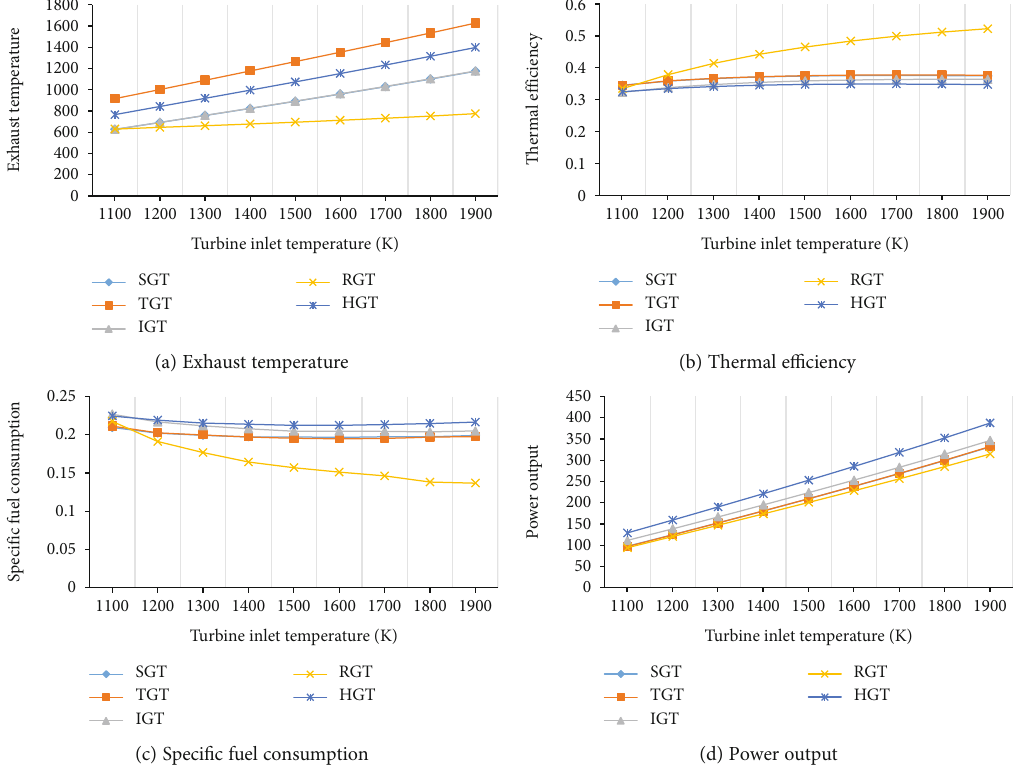
Figure 9: The impact of the TIT on the performance of the